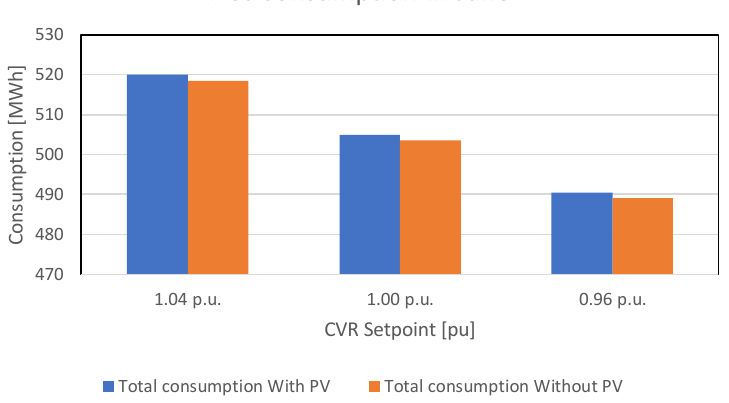
Figure 17. Effect of PV on energy consumed in June for different CVR setpoints.